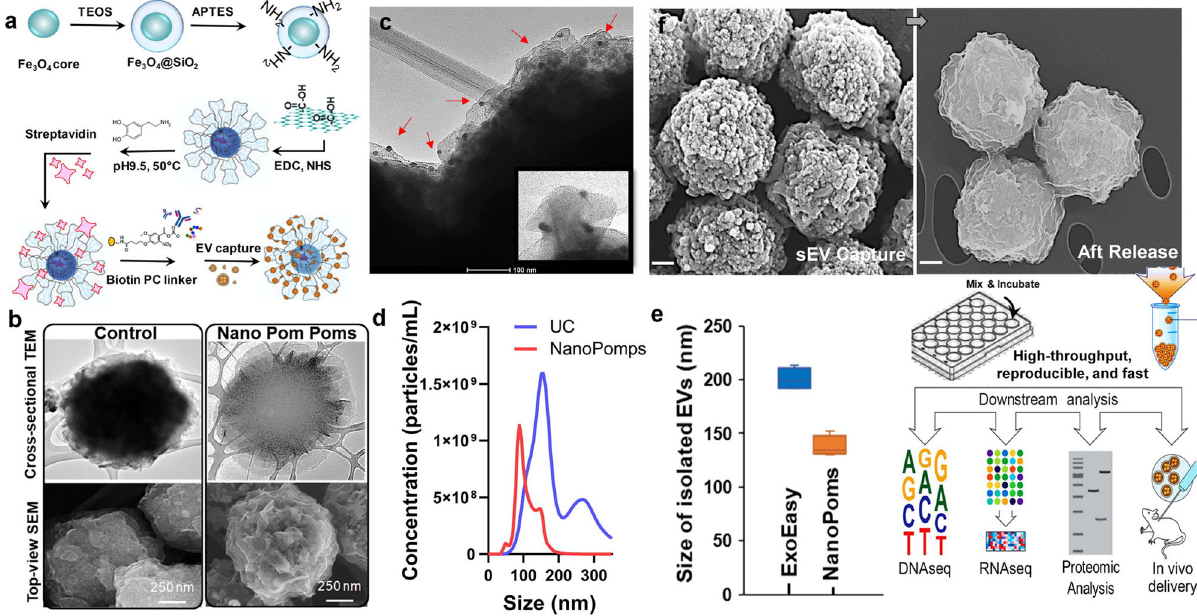
Fig. 1 Nano pom-poms fabrication for highly speci fi c exosome isolation and multi-omic biomarker analysis. a Schematic illustration of the fabrication of Nano pom poms. b TEM and SEM images showing the unique 3D nano-scale fl ower pom-poms morphology compared to commercial immunomagnetic beads. c The immune gold nanoparticle staining TEM imaging of captured exosomes fully covering Nano pom-poms surface. Captured EVs are con fi rmed by antiCD63 gold nanoparticles. The insert shows the captured single exosomes in the size range of ~100 nm with three gold nanoparticles bound (~10 nm). d Nanoparticle tracking analysis of NanoPoms isolated exosomes with much narrower size distribution in comparison with UC isolated EVs. e Nanoparticle tracking analysis of the size of NanoPoms isolated exosomes ( n = 4 independent experiments, mean ± SD), compared with ExoEasy isolation ( n = 4 independent experiments, mean ± SD), which showed reproducible and smaller size of exosomes from NanoPoms preparation. f SEM images showing the dense exosomes are captured covering the surface of Nano pom-poms, and can be completely released via on-demand photo- cleavage. After release, intact exosomes can be harvested for downstream multi-omic analysis including next generation sequencing of DNAs, RNAs, western blotting and proteomic analysis, as well as in vivo